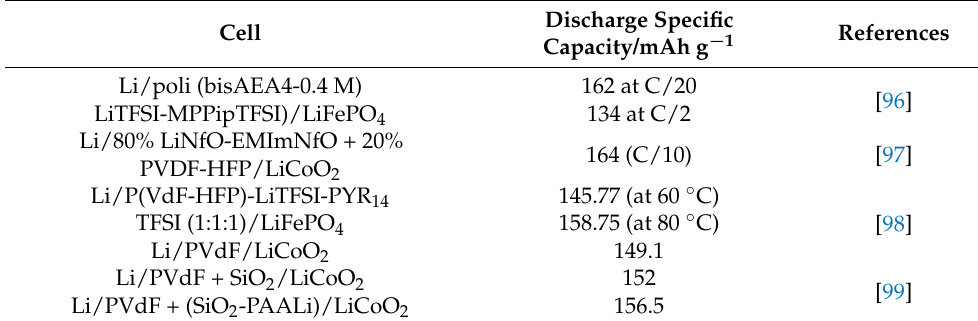
Table 5. Polymer electrolytes used in lithium-ion